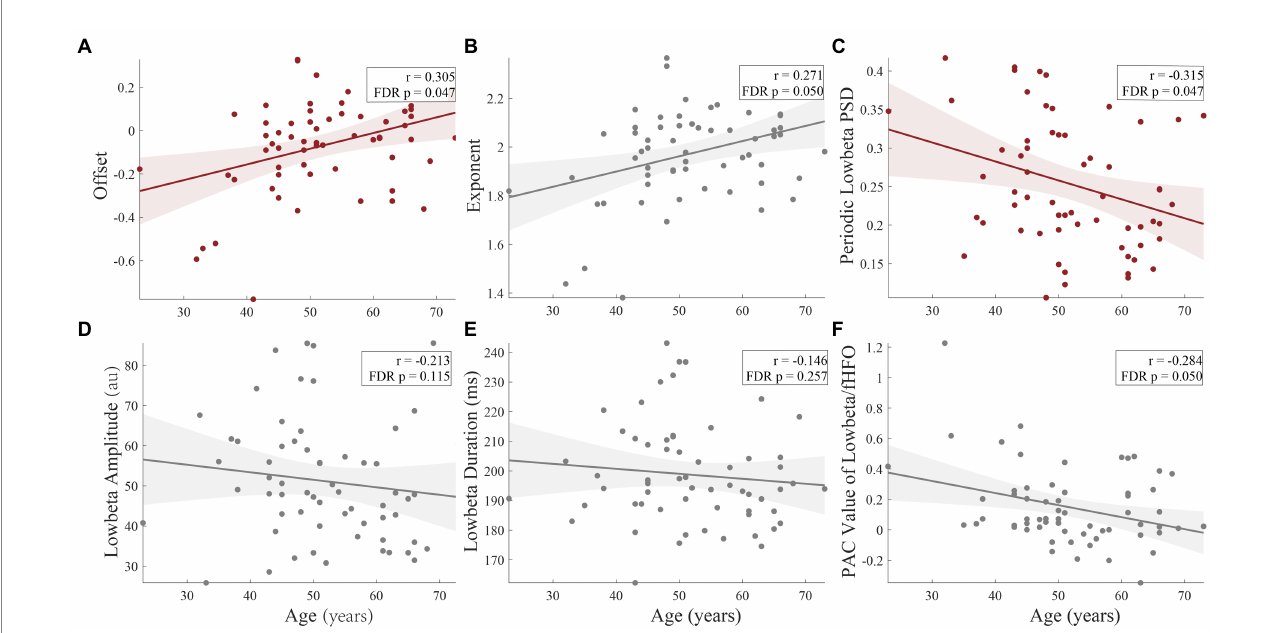
FIGURE 5 The correlations of age and the LFP parameters. There were significant correlations between age and offset ( r = 0.305, FDR corrected p = 0.047), (A) and periodic low-beta PSD ( r = − 0.315, FDR corrected p = 0.047), (C) in whole population. Moreover, exponent ( r = 0.271, FDR corrected p = 0.050), (B) and PAC value of low-beta/fHFO ( r = −0.284, FDR corrected p = 0.050), (E) were marginal significantly correlated with age. The amplitude (FDR corrected p = 0.115) (D) and duration (FDR corrected p = 0.257) (F) had no significant correlations with